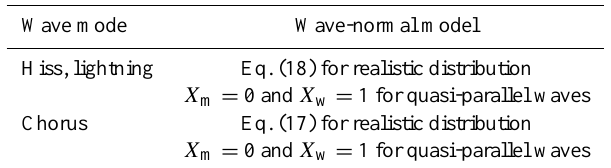
Table 1. Wave-normal angle models for the different wave